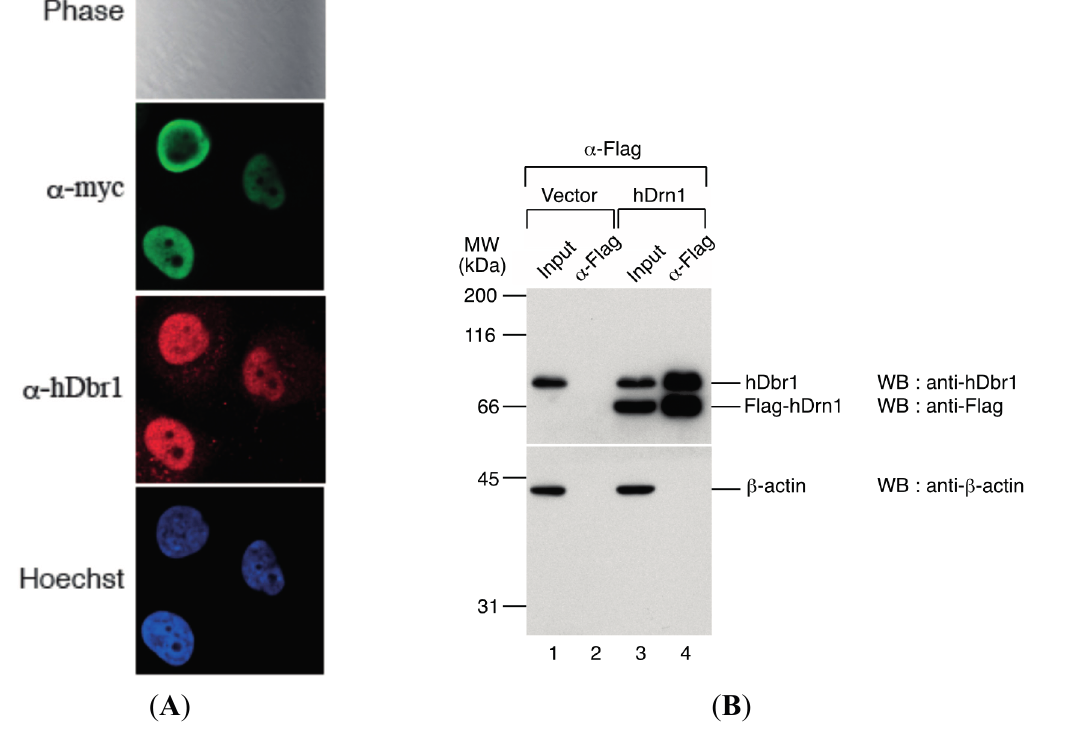
Figure 4. hDrn1 localizes to the nucleoplasm in HeLa cells by immunofluorescence and co-immunoprecipitates with endogenous hDbr1. ( A ) The expression vector encoding myc-tagged hDrn1 was transfected into HeLa cells. Twenty-four hours after transfection, the cells were stained with anti-myc (M192-3, MBL, panel FITC, middle ), anti-hDbr1 16019-1-AP, Proteintech) and Hoechst 33342 (SIGMA, panel Hoechst, bottom ) to label the nuclei. Differential interference contrast (DIC) image of the cells is also shown as Phase panel at the top ; and ( B ) Co-immunoprecipitation of endogenous hDbr1 with Flag-hDrn1 in vivo . Flag-tagged hDrn1 was expressed in HEK293T cells and immunoprecipitated using anti-Flag M2 antibody (SIGMA). Co-precipitated fractions were separated using 12.5% SDS-PAGE gel and analyzed by Western blotting using anti-hDbr1 and anti-Flag polyclonal antibodies ( upper panel) and anti- β -actin antibody (MBL) ( lower panel). Input lanes contain 5% of the total proteins used for immunoprecipitation assays. The positions of protein mass markers are shown on the left in